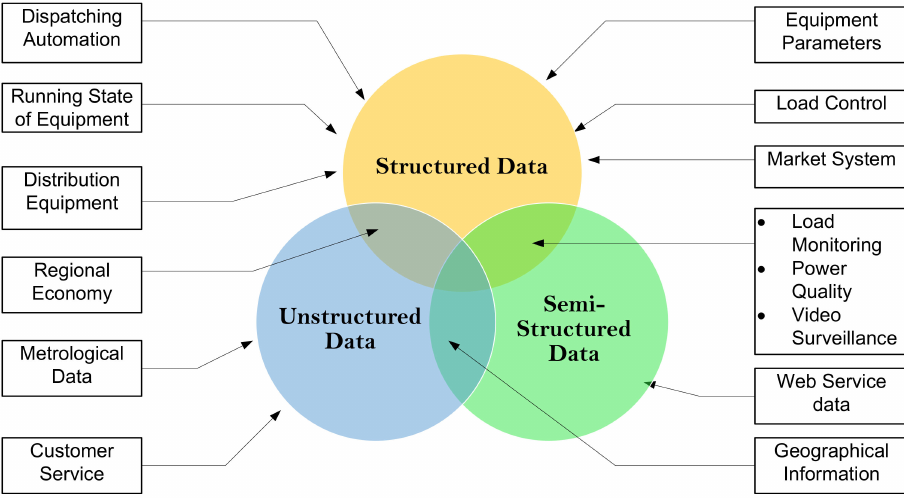
Figure 10. Data availability in a